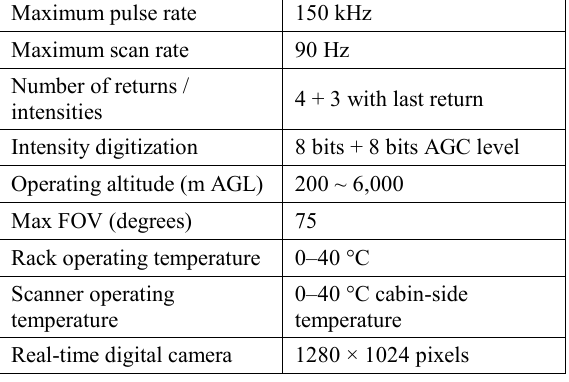
Table 1. Specifications of